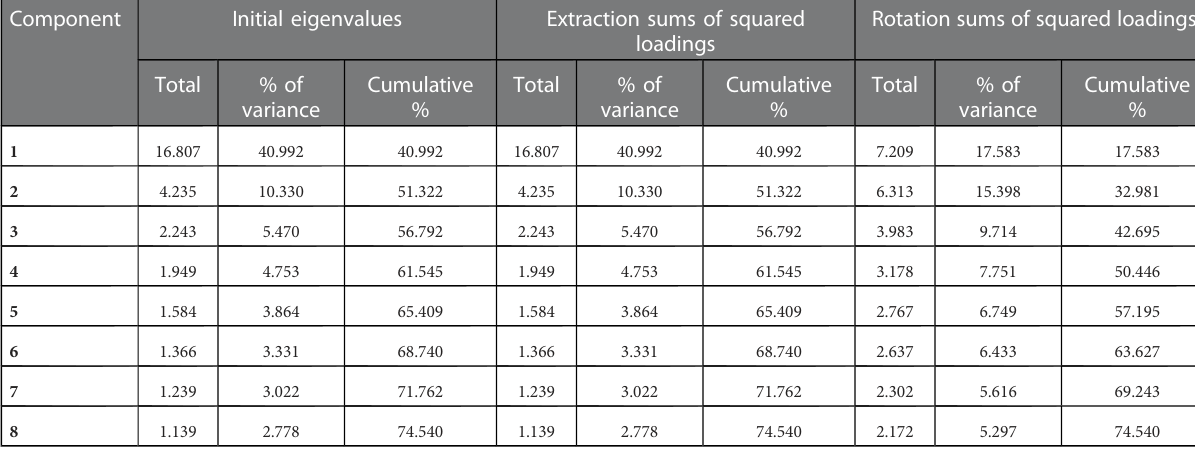
TABLE 6 Factors extracted by principal component analysis.